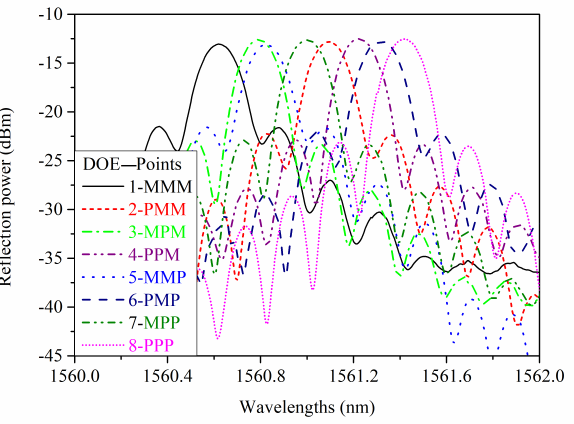
Figure 4. Reflection spectra of PI-FBG for any combination of three factors in two levels (M represents a low level ( − 1), and P a high level ( +